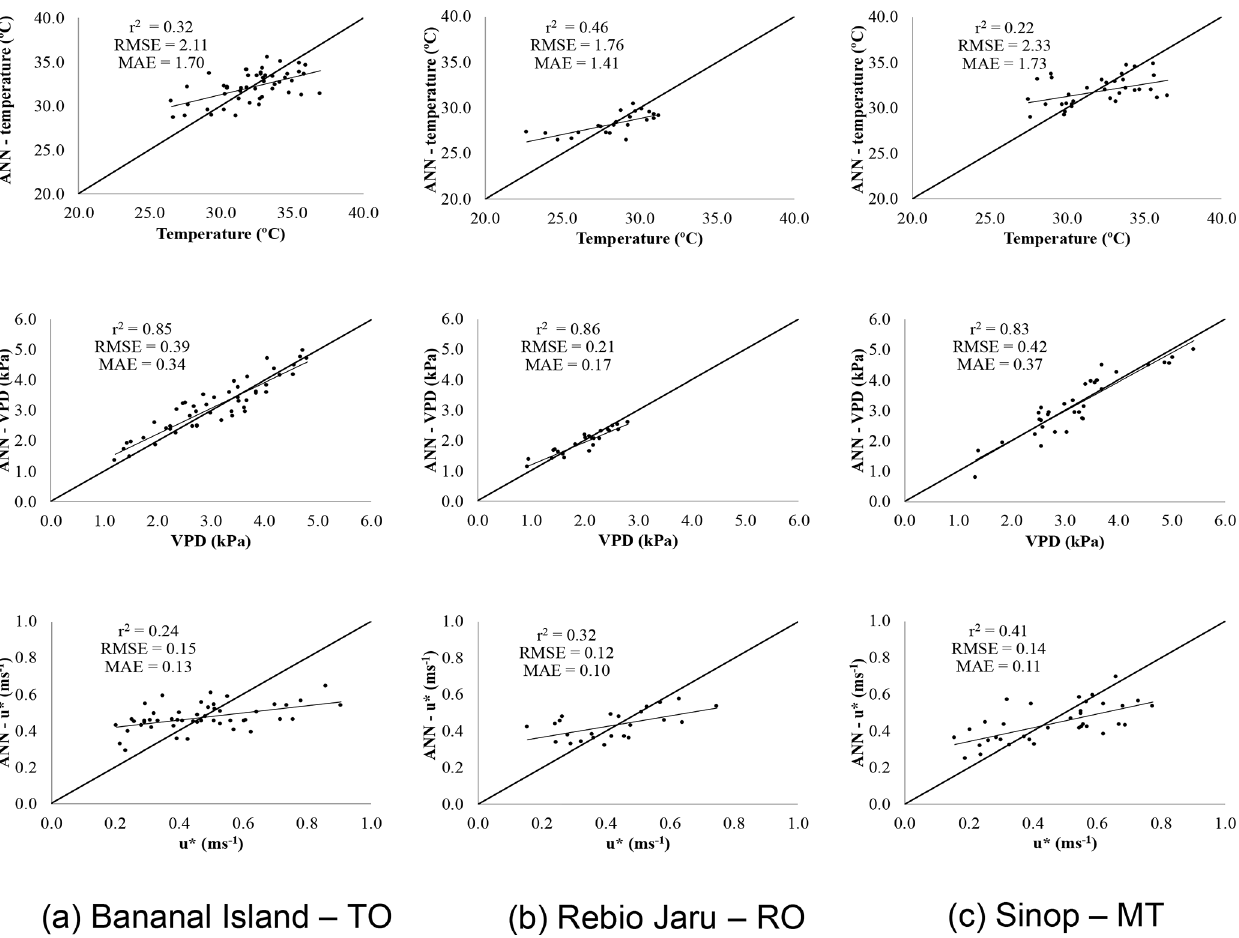
Figure 6. Temperature ( ◦ C), VPD (kPa), and u ∗ (ms − 1 ) obtained from ANNs generated with observed values for the three study sites, with respective r 2 , MAE, and RMSE. The 1 : 1 line (thick) and the best linear fit (thin) are also